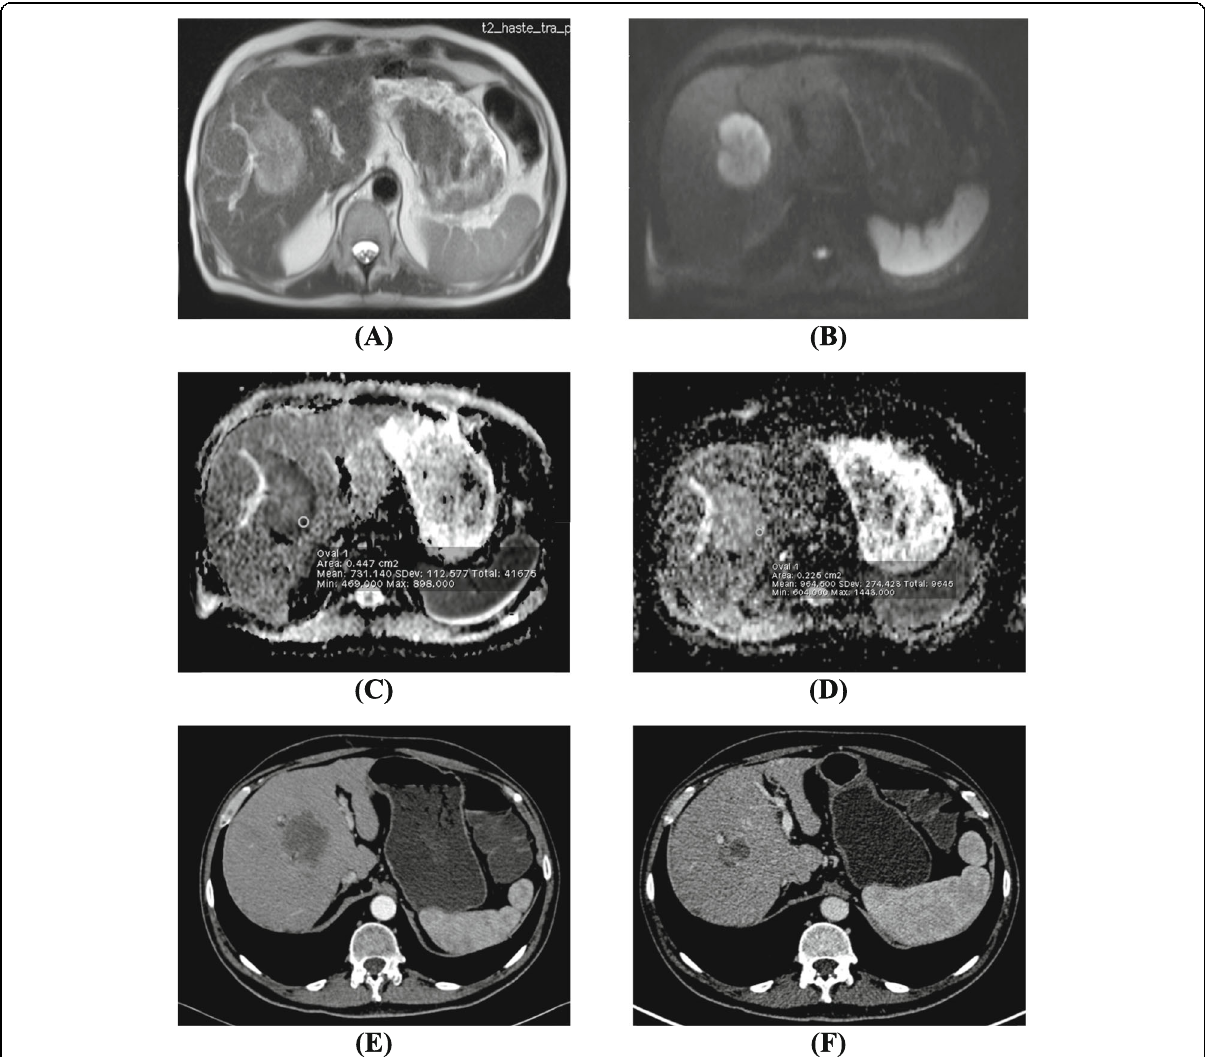
Fig. 5 Case (2): A 57 year old male patient with history of rectal adeno-carcinoma with hepatic metastasis. a ) Baseline axial T2 MRI revealed mostly hyper intense lesion in segment VIII/V interface. b ) Corresponding axial baseline diffusion weighted image of the previous T2 target lesion with b value of (800 m2/sec) shows the lesion displaying hyper intense signal. c ) pre therapeutic ADC image which revealed diffusion restriction and ADC value of 0.73 x10-3 m2/sec. ( d ) post therapeutic (21 days after chemotherapy) ADC map showing increase in the ADC value up to 0.96 x10-3 m2/sec ( e ) base line pre chemotherapy CT portal phase; hypo dense lesion with relative peripheral enhancement was noted measuring about 5.6 cm. ( f ) 2 month follow up CT portal phase revealed significant reduction of the lesion currently seen measuring about 2.3cm (partial response according to RECIST